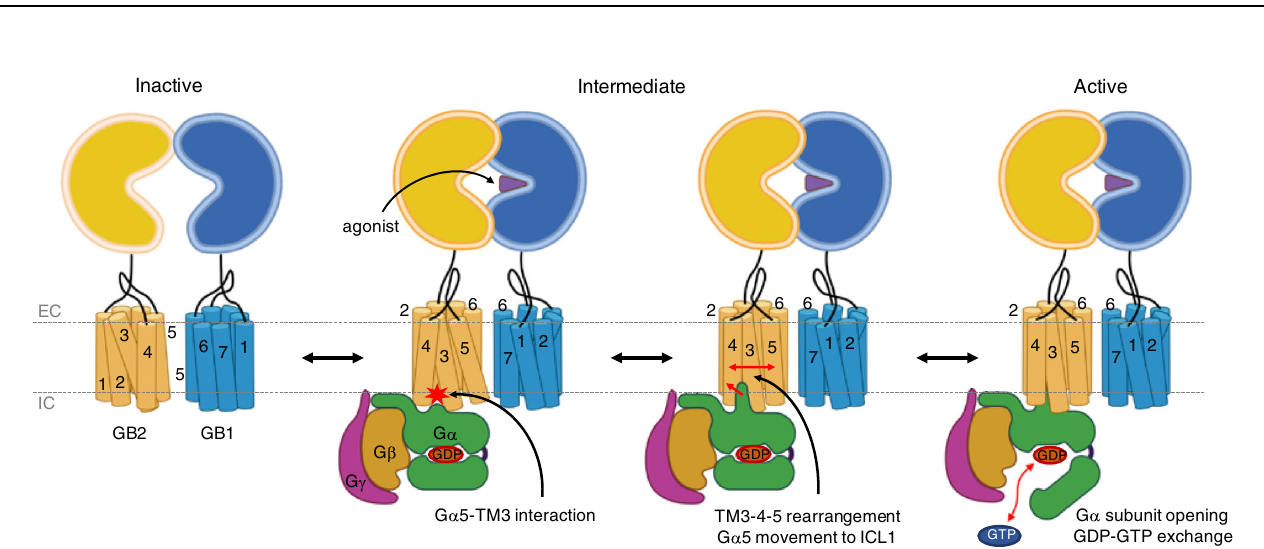
contacttoTM3, b butopeningoftheG α subunitbecomesfavourablewhentheG α 5 helix is inserted more deeply to interactwith ICL1. The G α opening distances were measuredbetween thecentreof mass of C α forresidues 44 – 58inRas-like domain, and 150 – 166 and 170 – 178 of AH domain.